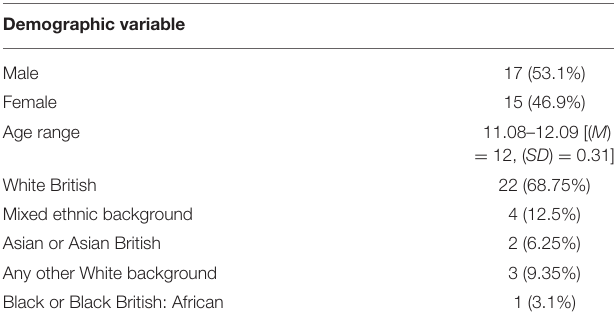
TABLE 1 | A summary of the demographic data for the young people included in the